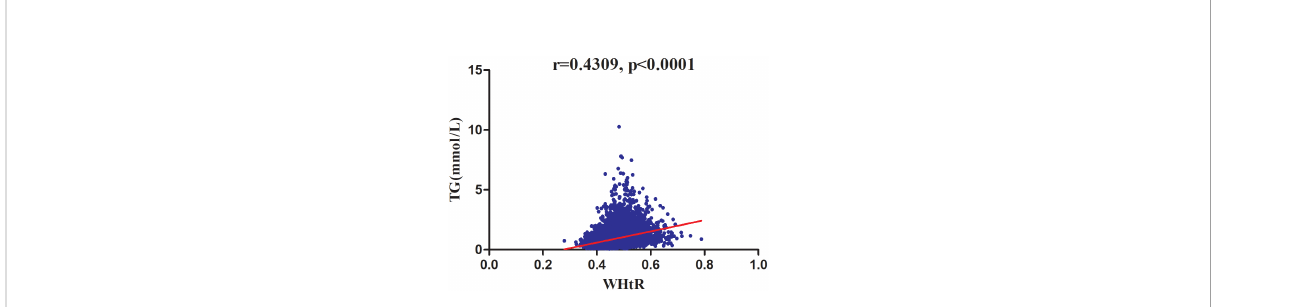
FIGURE 5 Correlation analysis of WHtR and TG. Correlation analysis results showed that WHtR was positively correlated with TG (r=0.4309, P <0 .0001) (Figure